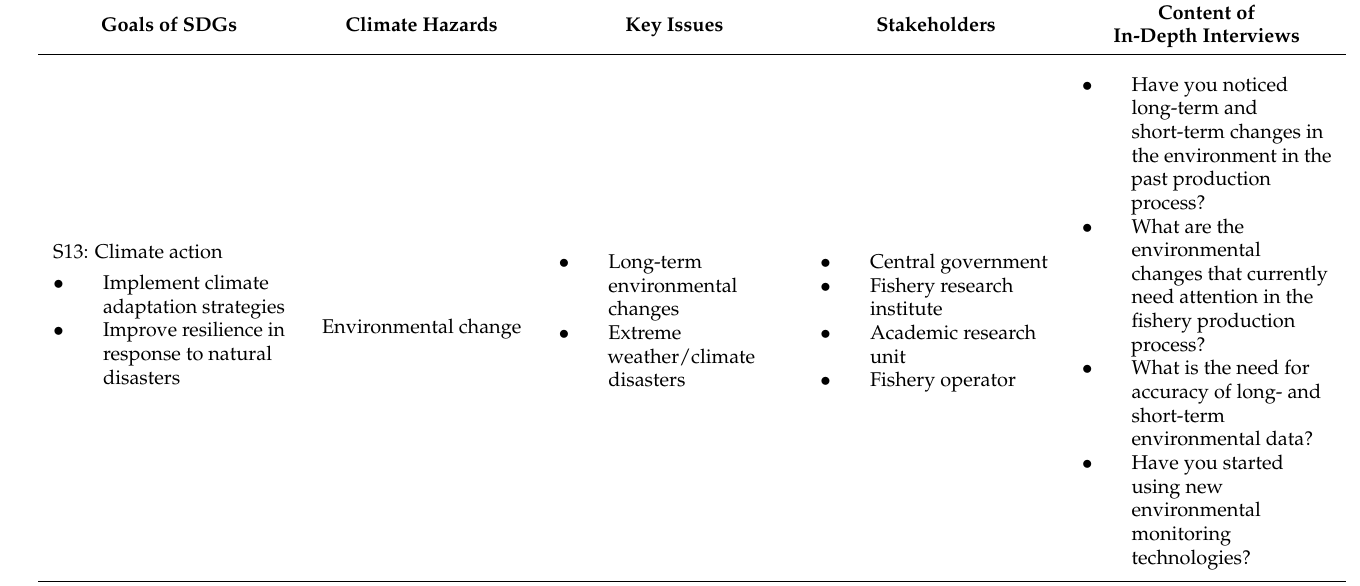
Table 2. Content of in-depth interviews linked to the United Nations sustainable development goals